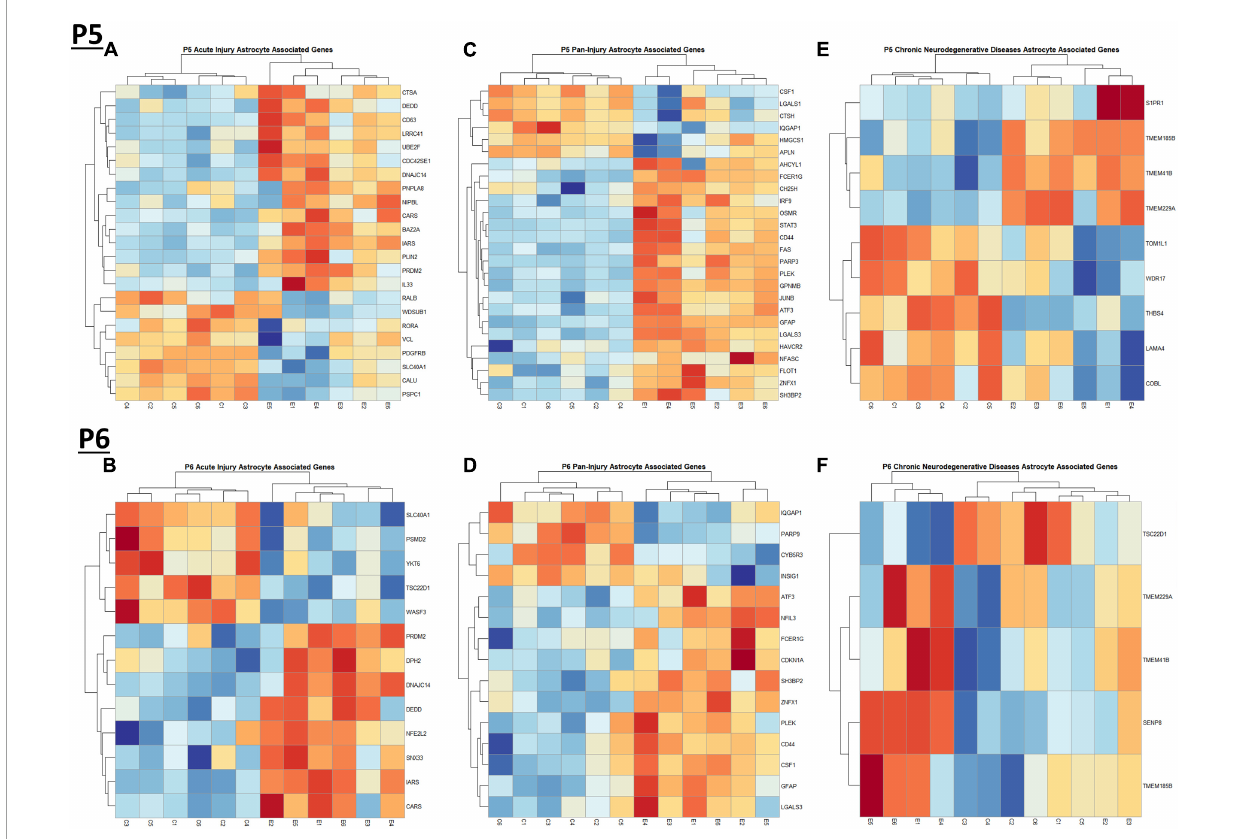
FIGURE5 Heatmap and hierarchical clustering of astrocyte associated genes at P5 and P6. R statistical software was utilized to construct heatmaps and hierarchical clustering dendrogram of relative gene expression across samples for significantly altered (adj. p < 0.05) and categorized astrocyte associated genes as detailed in Methods. Astrocyte acute injury astrocyte associated gene expression is depicted in panel (A) for P5 and panel (B) for P6. Astrocyte pan-injury astrocyte associated gene expression is depicted in panel (C) for P5 and panel (D) for P6. Astrocyte chronic neurodegenerative diseases astrocyte gene expression is depicted in panel (E) for P5 and (F) for P6.